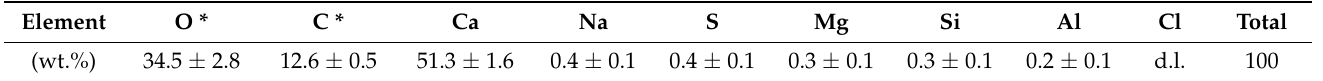
Figure 2. Particle size distribution of ( a ): Scallop shells and ( b ): cement used in this study. Table 1. Calcium is the major element. The analysis also shows the presence of traces of S, Na, Mg, S, and Al (<0.4 wt.%). Table 1. Chemical composition of SS obtained by energy dispersive spectroscopy on ground SS